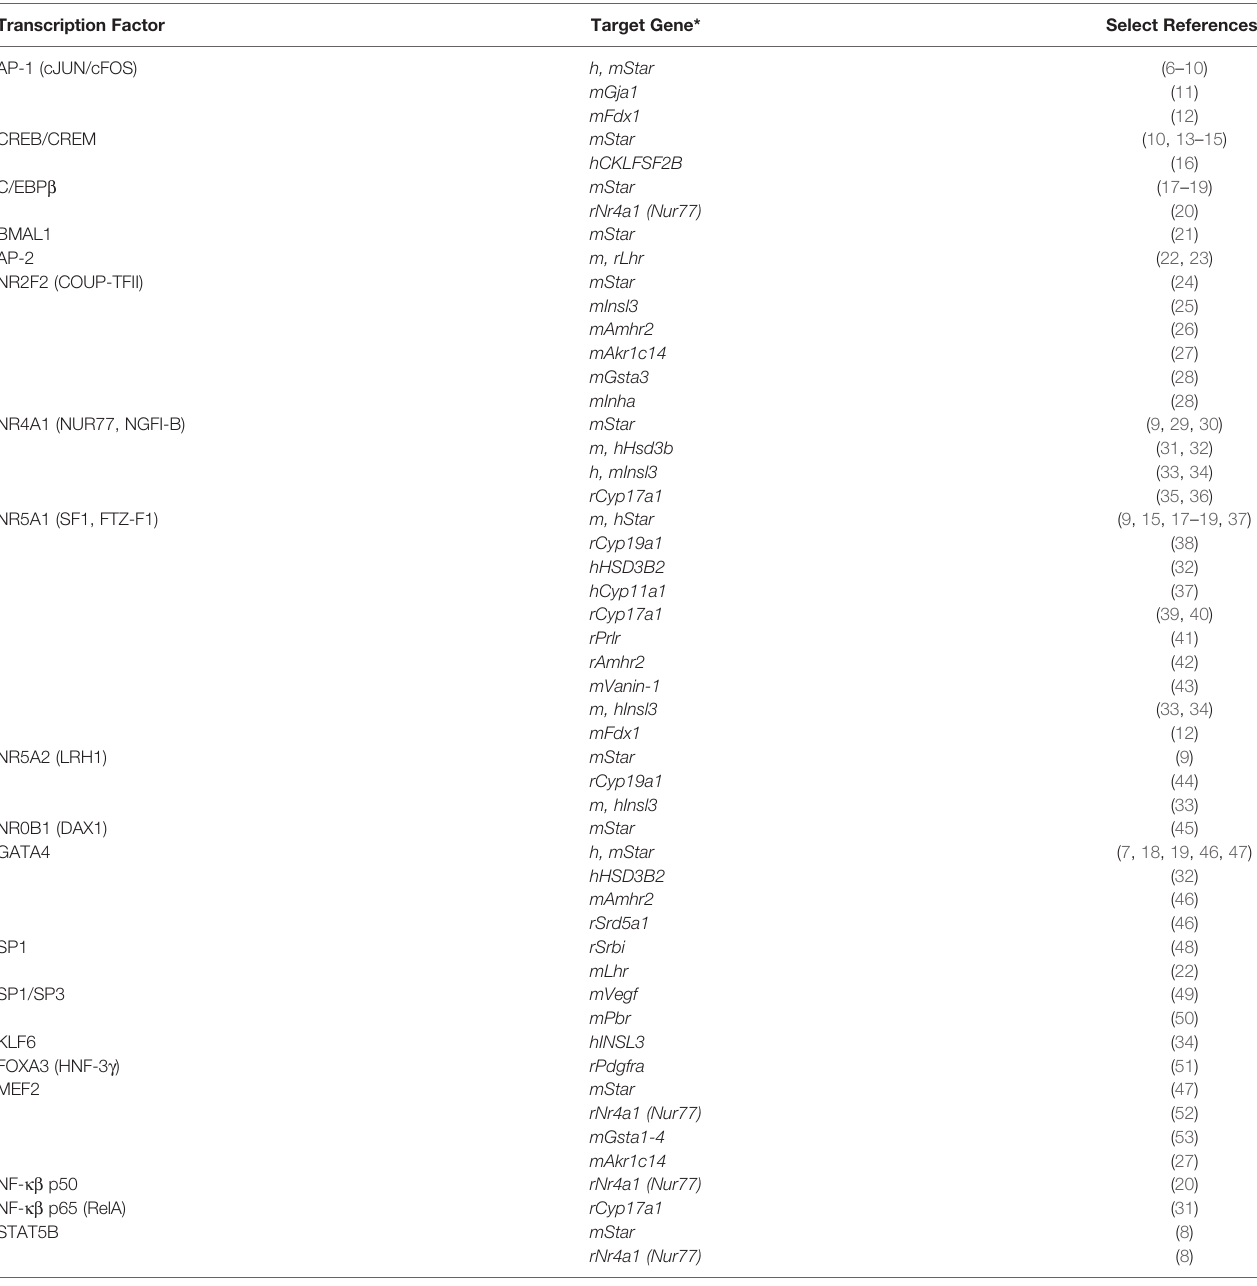
TABLE 2 | Transcription factors and their target genes in Leydig